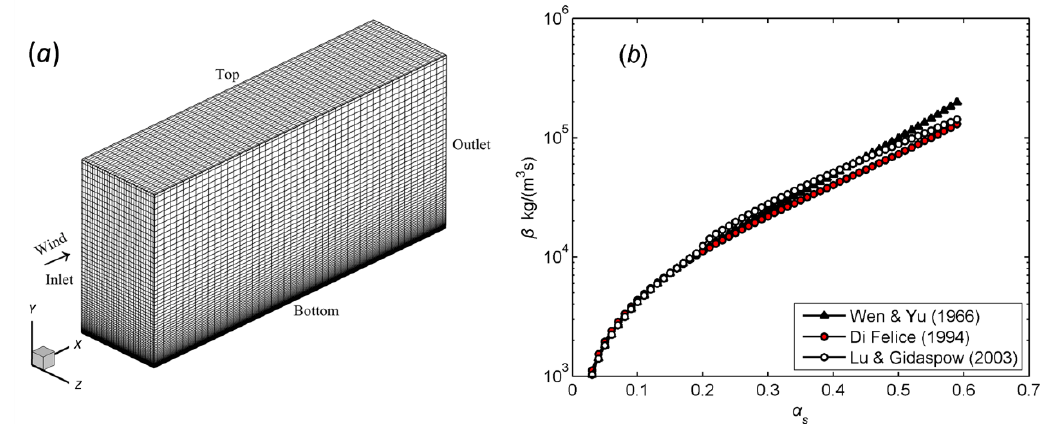
Figure 1. Preparation for simulation. ( a ) Rectangular computation domain with a size of L X × L Y × L Z = 0.2 m × 0.1 m × 0.05 m. The grid resolution is determined to be N X × N Y × N Z = 48 × 64 × 32 as the result of a convergence test. ( b ) Selection of the model for the drag coe ffi cient, in which three classic models are qualitatively similar to each other.